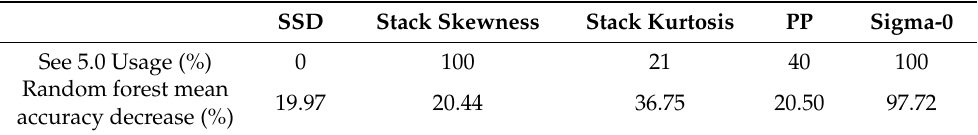
Table 5. Relative variable importance (i.e., contribution) to lead detection using See 5.0 and random forest by IC.